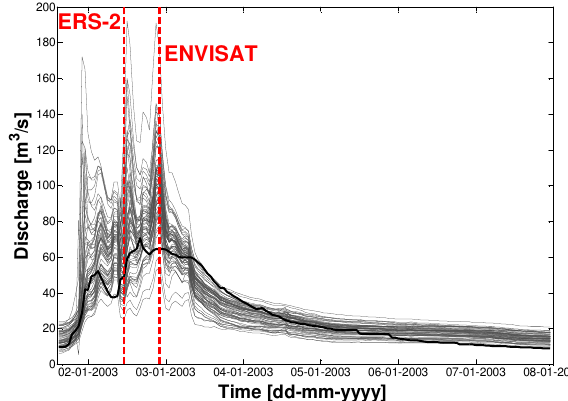
Fig. 5. Ensemble of the 64 upstream boundary conditions generated by the CLM 2.0. The gauged flow is also shown in bold line and the time of the two satellite overpasses are